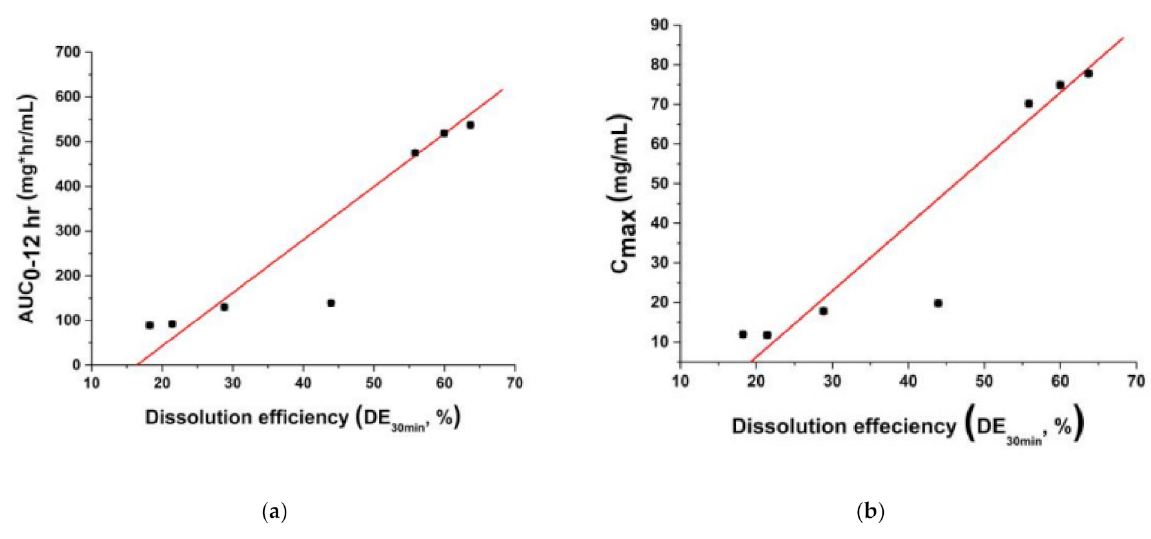
Figure 11. Relationship ( a ) between dissolution efficiency and AUC 0–12 h and ( b ) between dissolution efficiency and C max . A linear fit is presented as a dashed line that is intended as a guide for the eye and to indicate the relationship presented in the